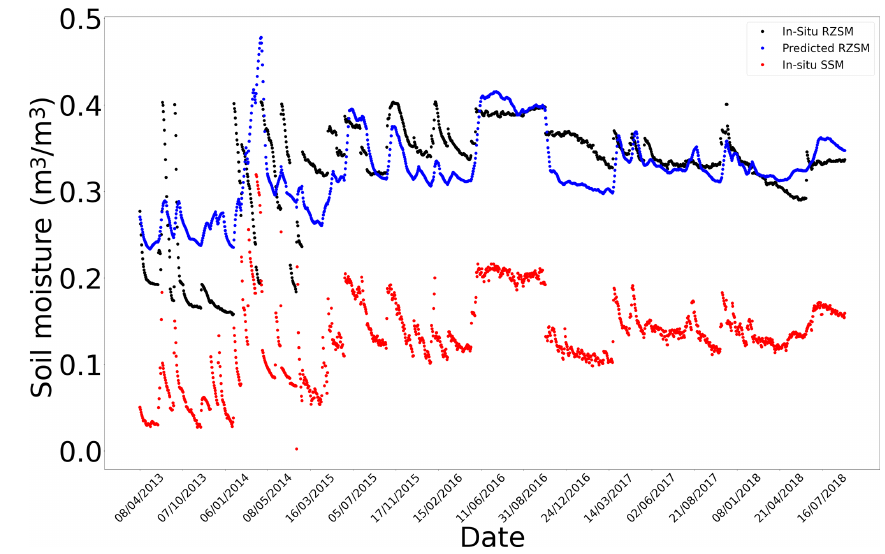
Figure F7. In situ SSM, in situ RZSM, and predicted RZSM series at station Widgiewa with model ANN_SSM.